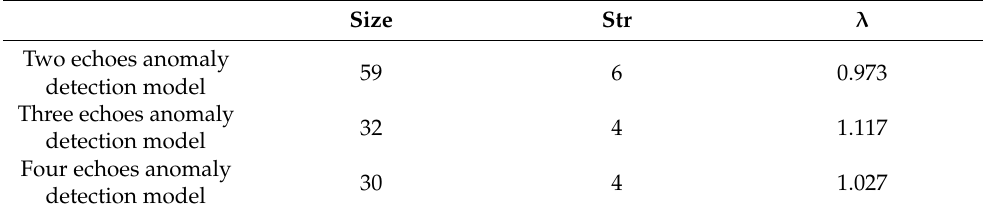
Table 4. Abnormal detection model parameter setting.